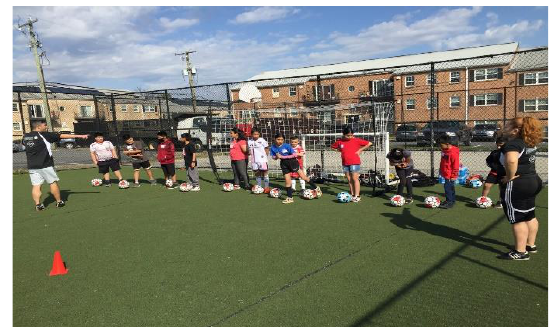
Figure 4. Youth soccer session.